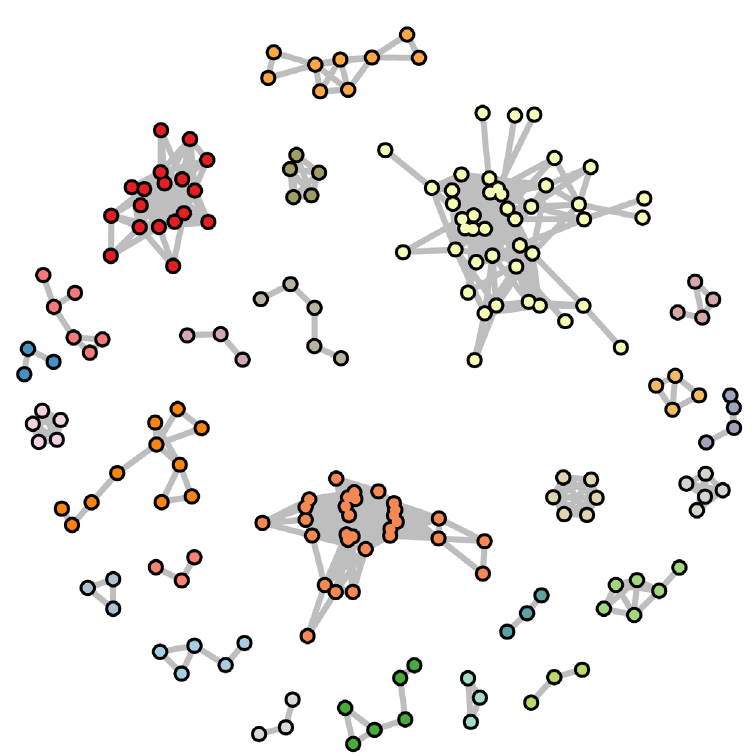
Figure 4. Disjoint clusters after community detection and